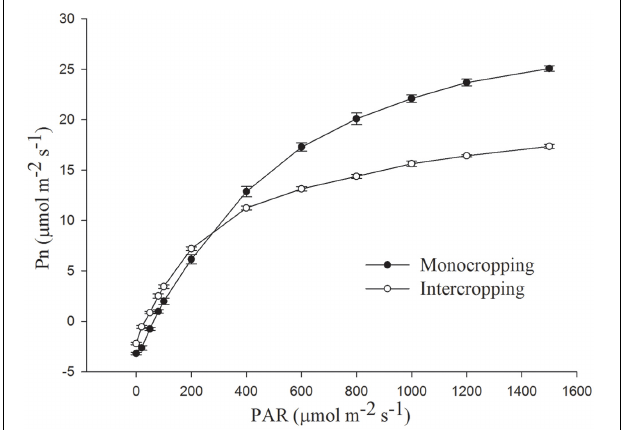
FIGURE 2 | Net photosynthetic rate, measured as CO 2 uptake in soybean leaf under monocropping and intercropping.